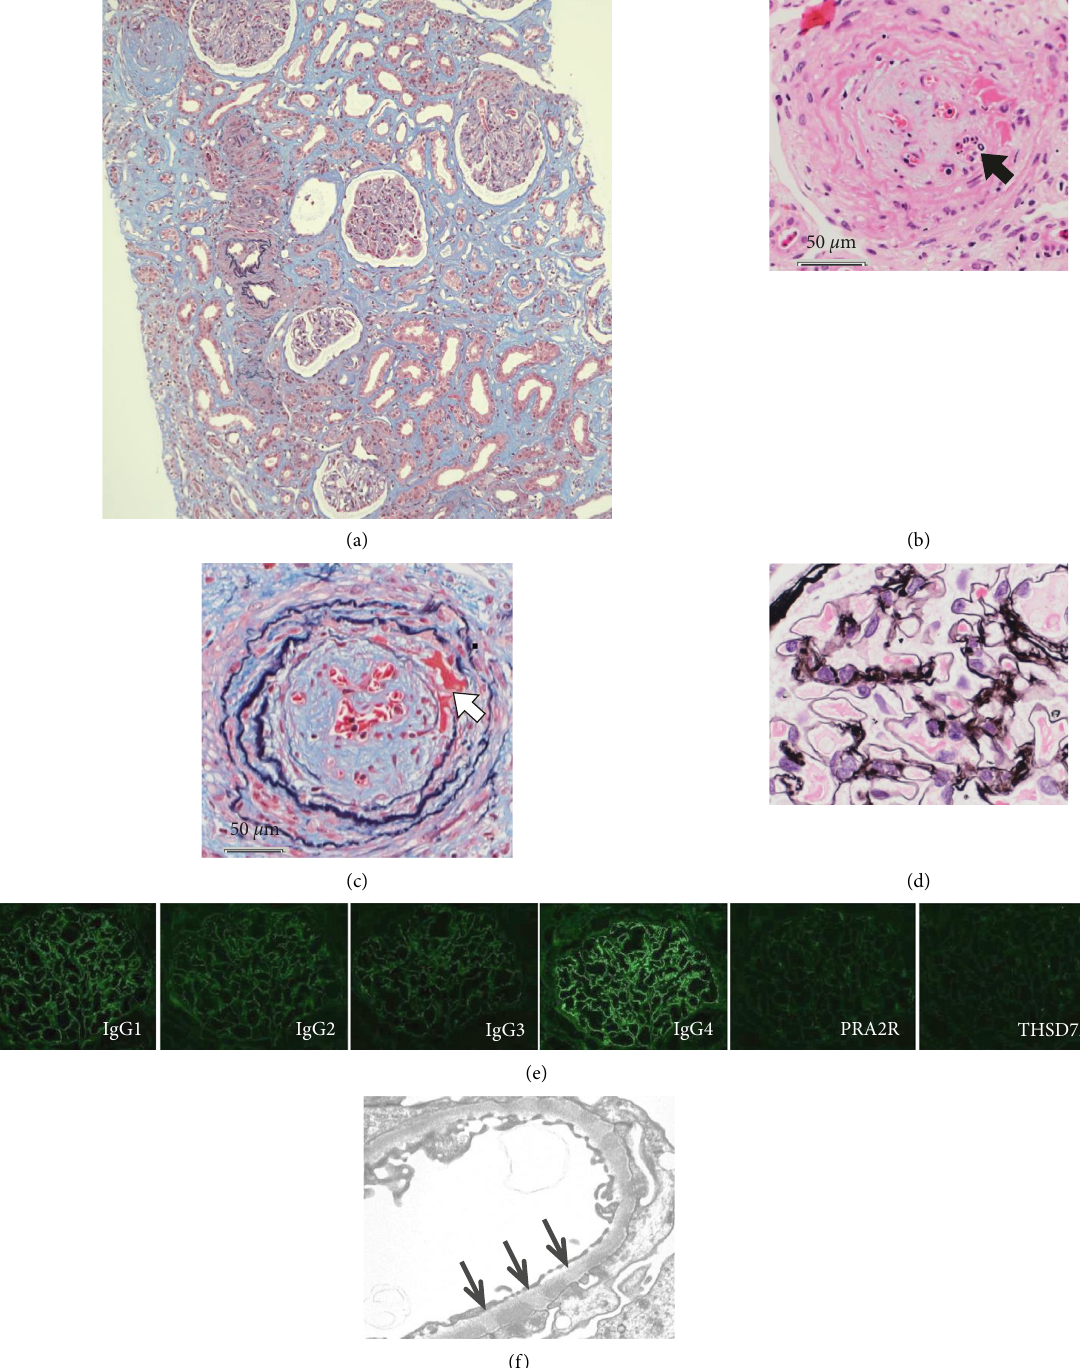
Figure 1: Histological findings of the renal specimen. Light microscopy image showing infiltration of inflammatory cells in the interstitial area and a severe degree of interstitial fibrosis and tubular atrophy (about 60%) but without granulomas ((a): PAS staining, original magnification 100). Among the interlobular arteries, some show inflammatory cell infiltration in the lumen ((b): black arrow, hematoxylin × and eosin staining, original magnification 400), fibrin deposition in the vascular wall, and rupture of the elastic fibers ((c): white arrow, PAS × staining, original magnification 400). There are no significant abnormal findings in the glomerulus, including membrane changes ((d): × periodic acid-methenamine silver staining, original magnification 400). As shown in the micrograph of fluorescence immunostaining ((e): × original magnification 400), glomerular capillary deposits are dominant in IgG4. PLA2R and THSD7A are negative, suspicious of a × secondary pathology. Electron microscopy image ((f): original magnification 3000) showing subepithelial electron-dense deposits (EDDs) × and a thickened basement membrane with spike formation (arrow). EDDs are limited to the subepithelium and are relatively uniform in size and distribution, which is not a finding of a secondary